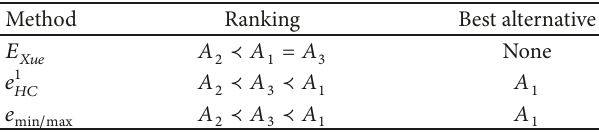
Table 10: Ranking of alternatives by different